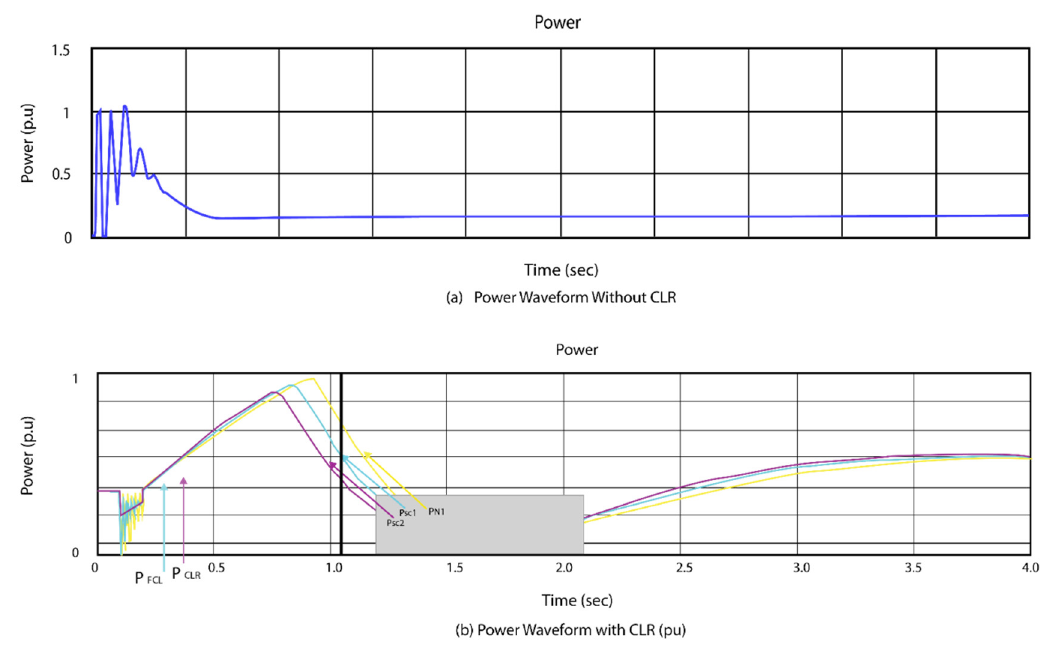
Figure 10. Instantaneous power waveforms due to the CLR’s resistance (pu).